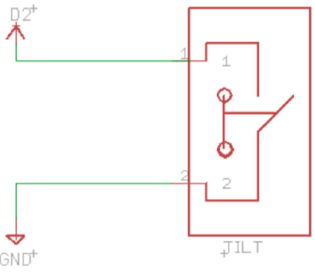
Figure 6. Tilt schematic. Figure 6. Tilt